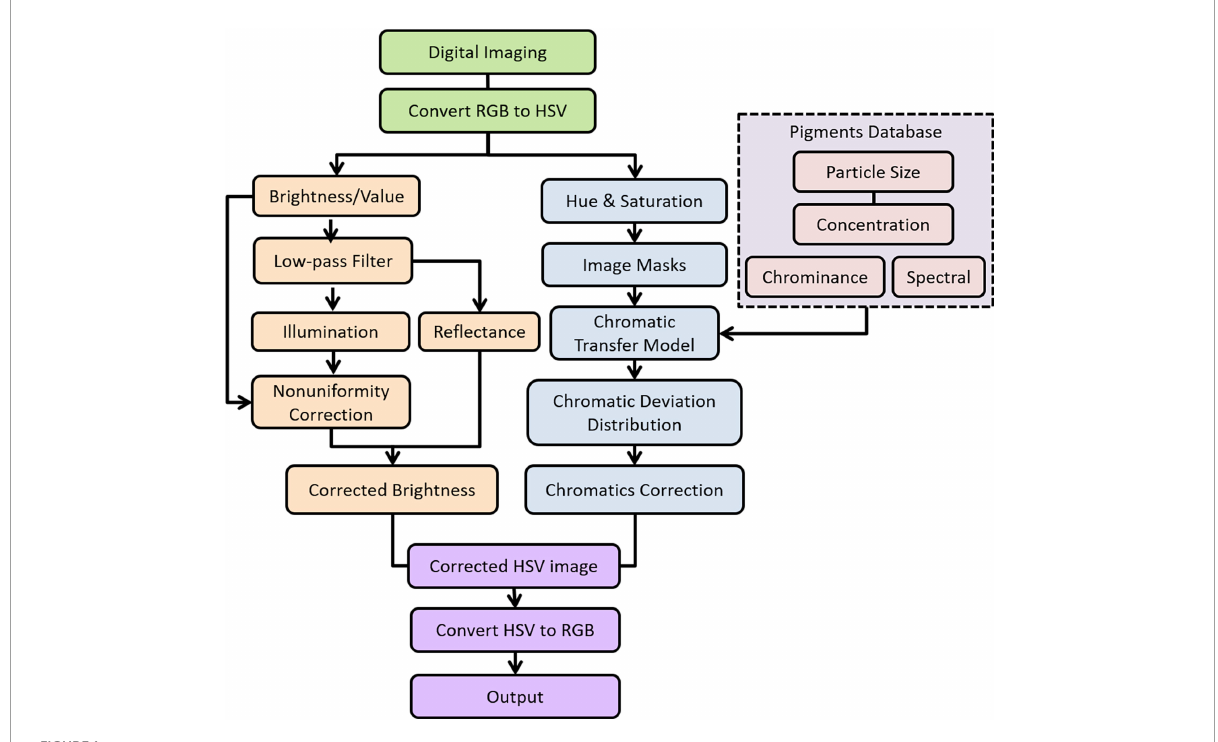
FIGURE1 Schematic diagram for proposed